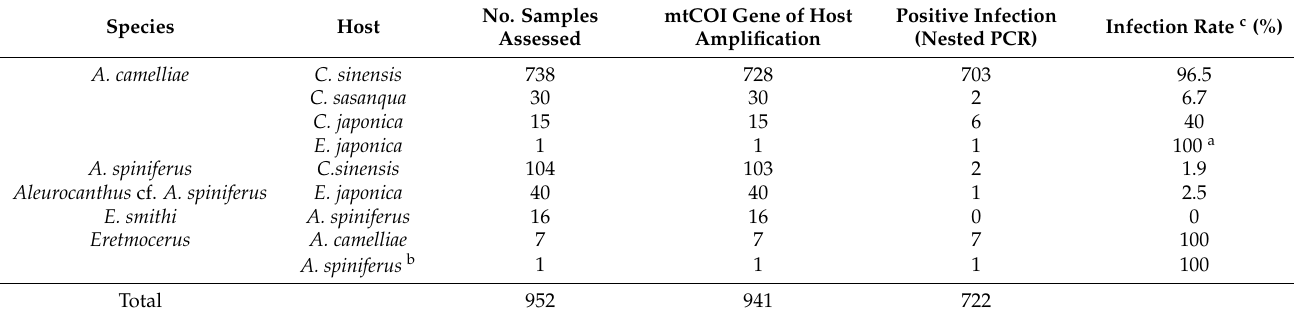
Table 3. Infection status of Wolbachia using nested